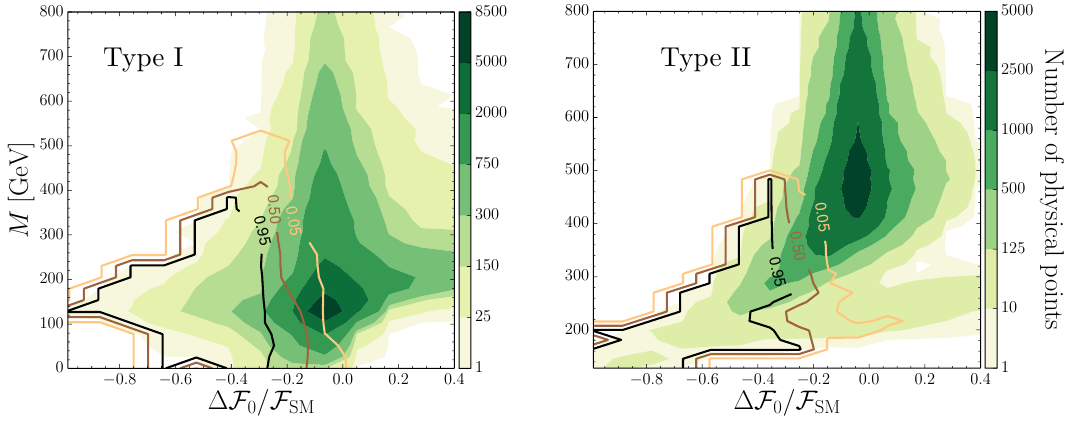
Figure 3 . Distribution of physical points, as in (cid:12)gure 1, and SM ((cid:1) = ; M ) 0 F 0 F